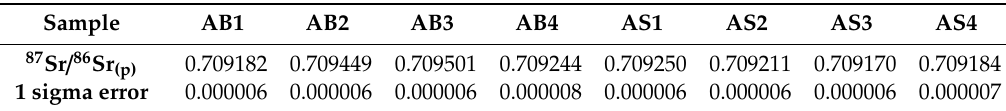
Table 2. Sr isotope compositions in apatite of Ghareh